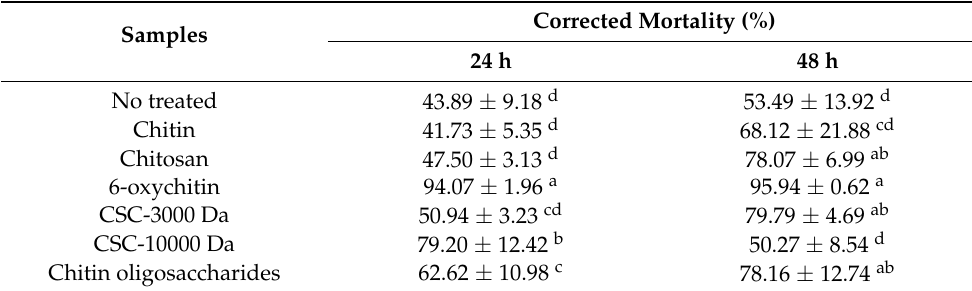
Table 2. Effect of chitin derivatives on the nematicidal activity of Purpureocillium lilacinum against M. incognita J2s in